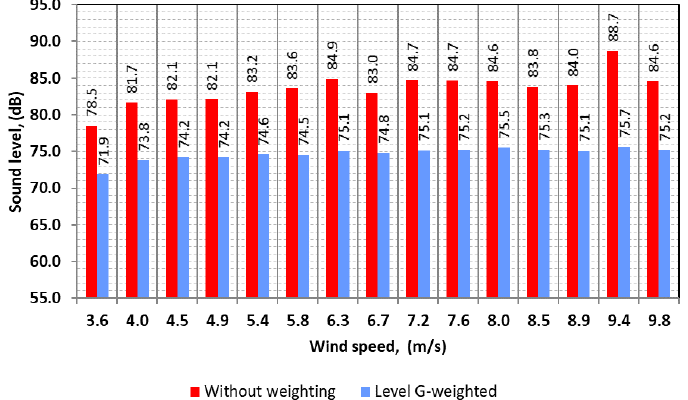
Figure 10. Comparison of variations in noise levels in the function of wind speeds–T1 turbine.